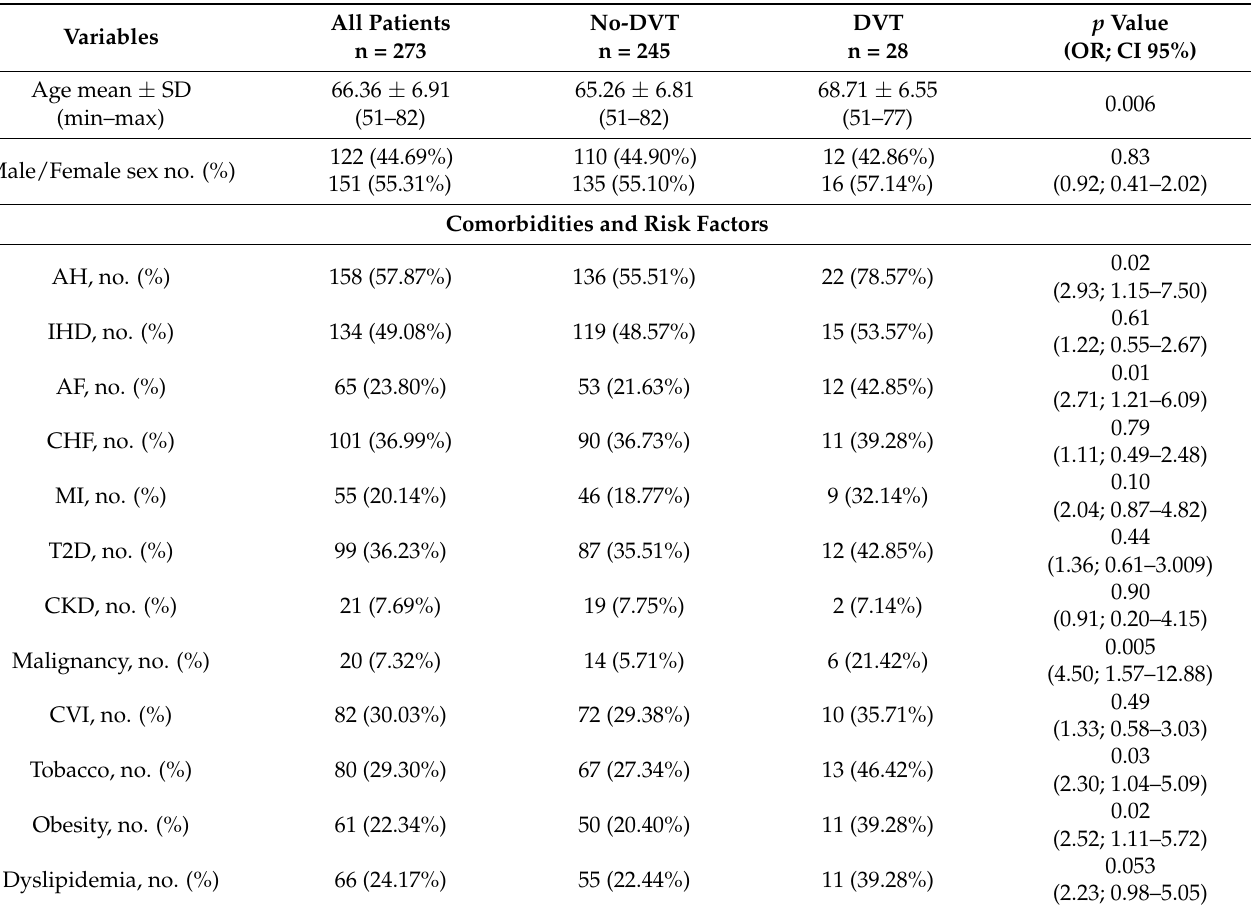
Table 1. The baseline characteristics data of all patients and divided according to the DVT